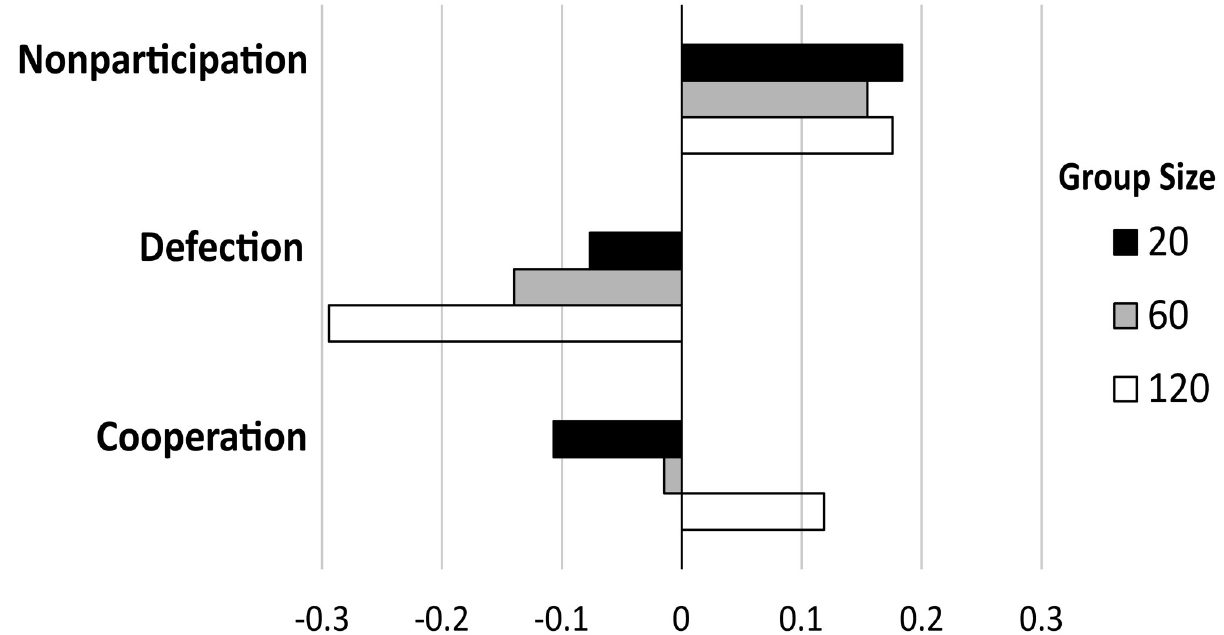
Fig 3. Differences in the long run average frequencies of behaviors across group sizes. Given the moderate level of nonparticipants’ payoff (0.925), each bar represents the difference calculated by subtracting the frequency of each behavior in the compulsory participation scenario from that in the voluntary participation scenario. Three different colors of bars represent group sizes. For instance, the bottom white bar shows that voluntary participation makes the long run average frequency of cooperation higher than compulsory participation, given that group size is large ( n = 120) and the nonparticipants’ payoff is moderate. The data used in this figure are provided in S2